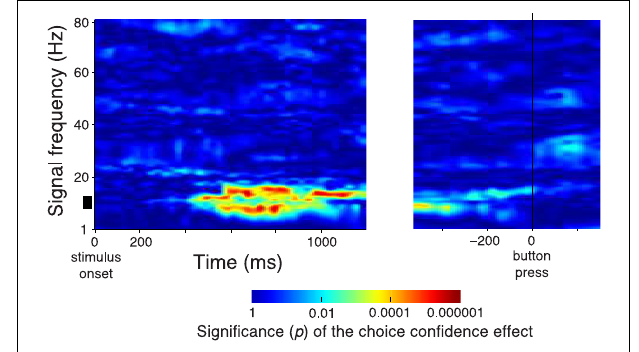
FIGURE 4 | The spectrum of the confidence-related neural effect at a single parietal channel CP3. Same format as in Figure 3A , for data at a single parietal channel